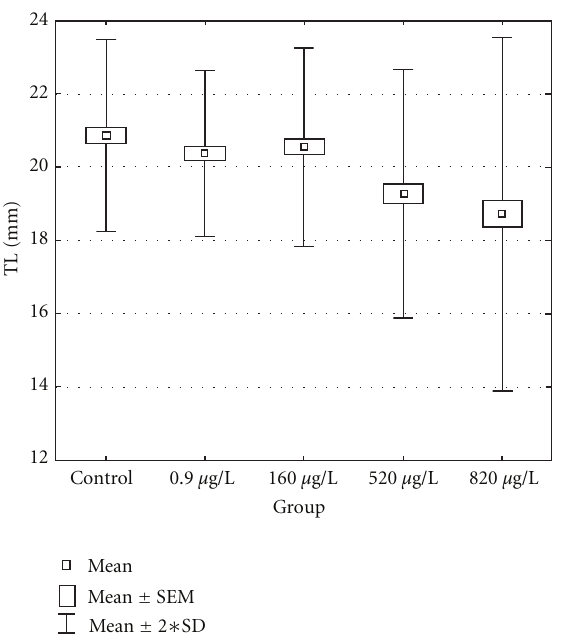
Figure 3: The variability of total body length of common carp after a 30-day embryolarval toxicity test; n = 225.